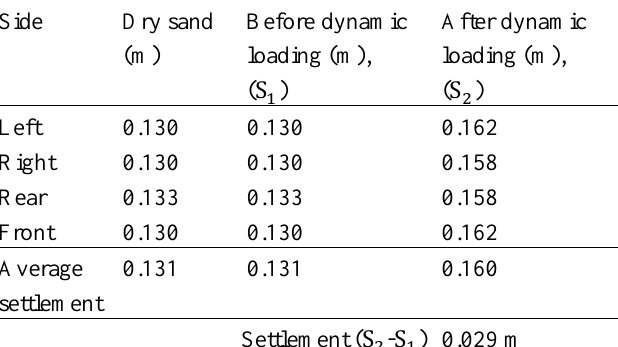
Settlement of Ground from Sides of the Structure in Treated 1-g Physical Model-II with Treatment Adjacent to Structure